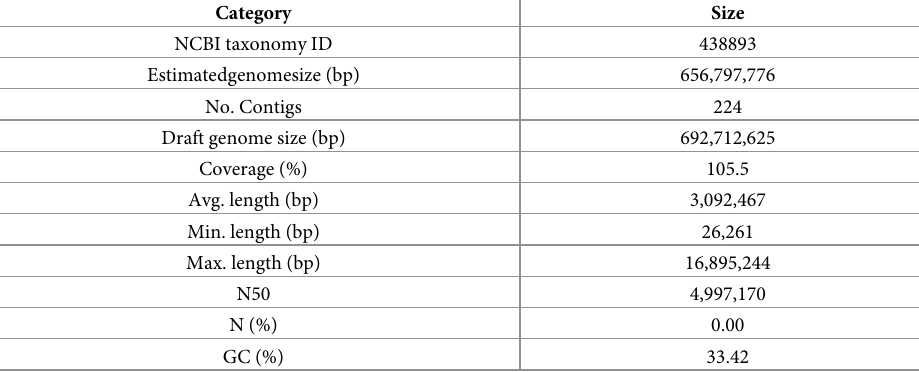
Table 1. Result of the genome assembly of P. b. seulensis